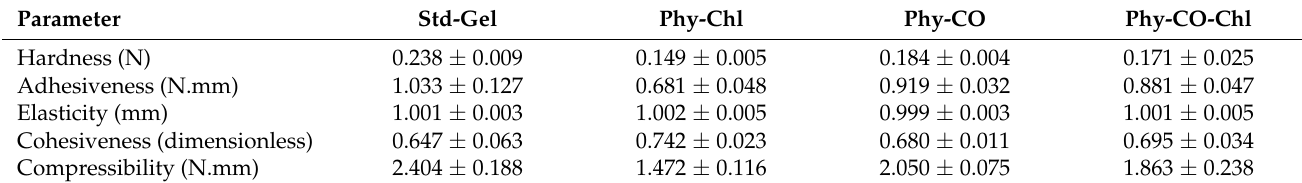
Table 3. Textural mechanical characteristics (hardness, adhesiveness, elasticity, cohesiveness, and compressibility) of gel formulations (mean ± standard deviation).